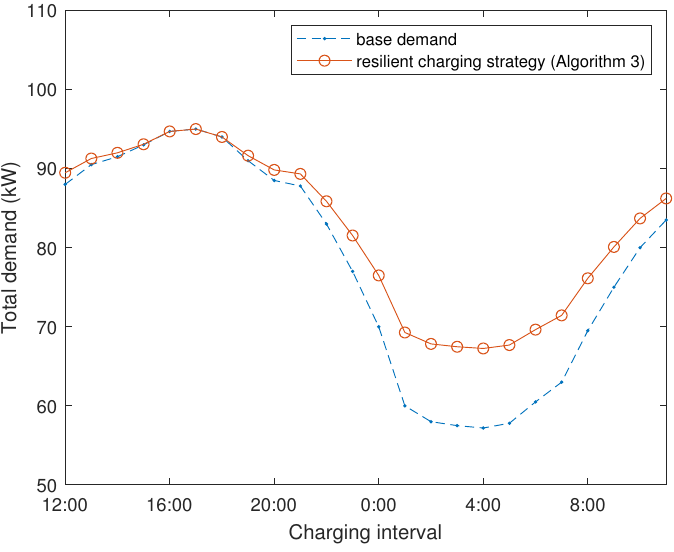
Figure 9. Aggregate demand for Algorithm 3 under replay attack or random